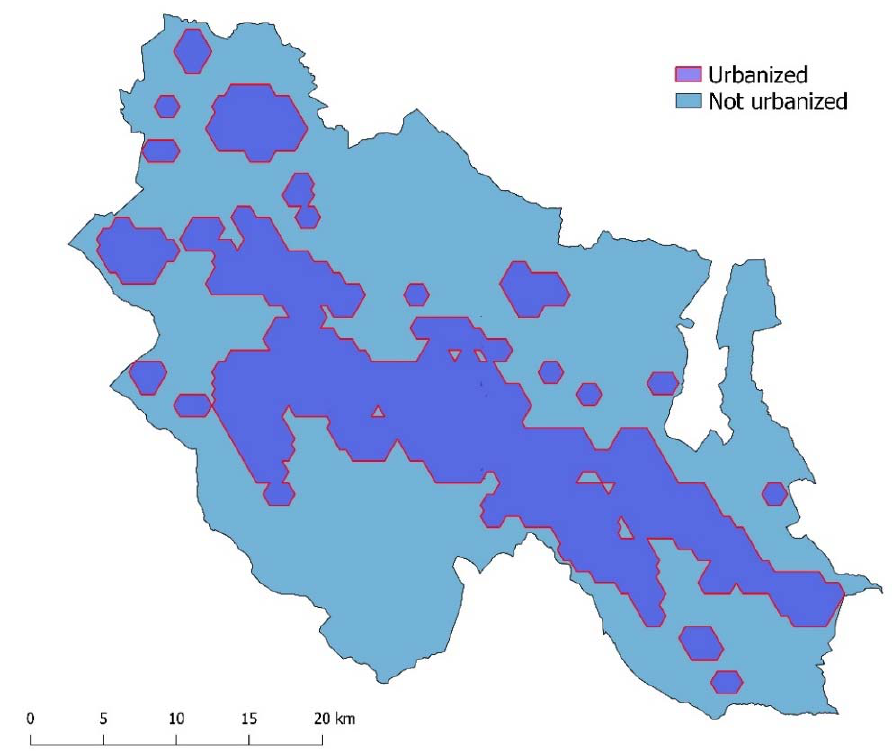
Figure 9. Final elaboration obtained dissolving all the urbanized cells resulting from the four K— Means method grid shifts, performed considering five UA classes.